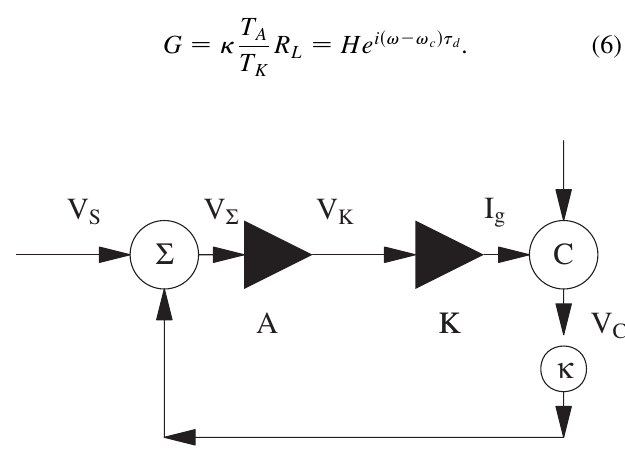
FIG. 1. Schematic of the longitudinal rf FB system. © 2007 The American Physical